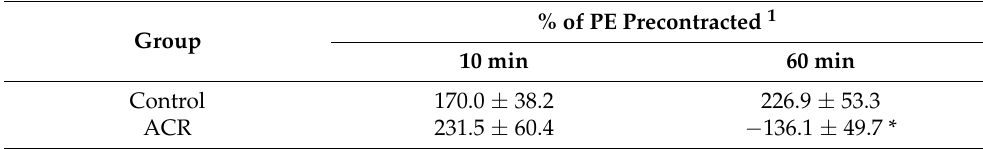
Table 2. Effects of calcium on acrylamide (ACR)-induced relaxation of the endothelium-denuded rat aortic